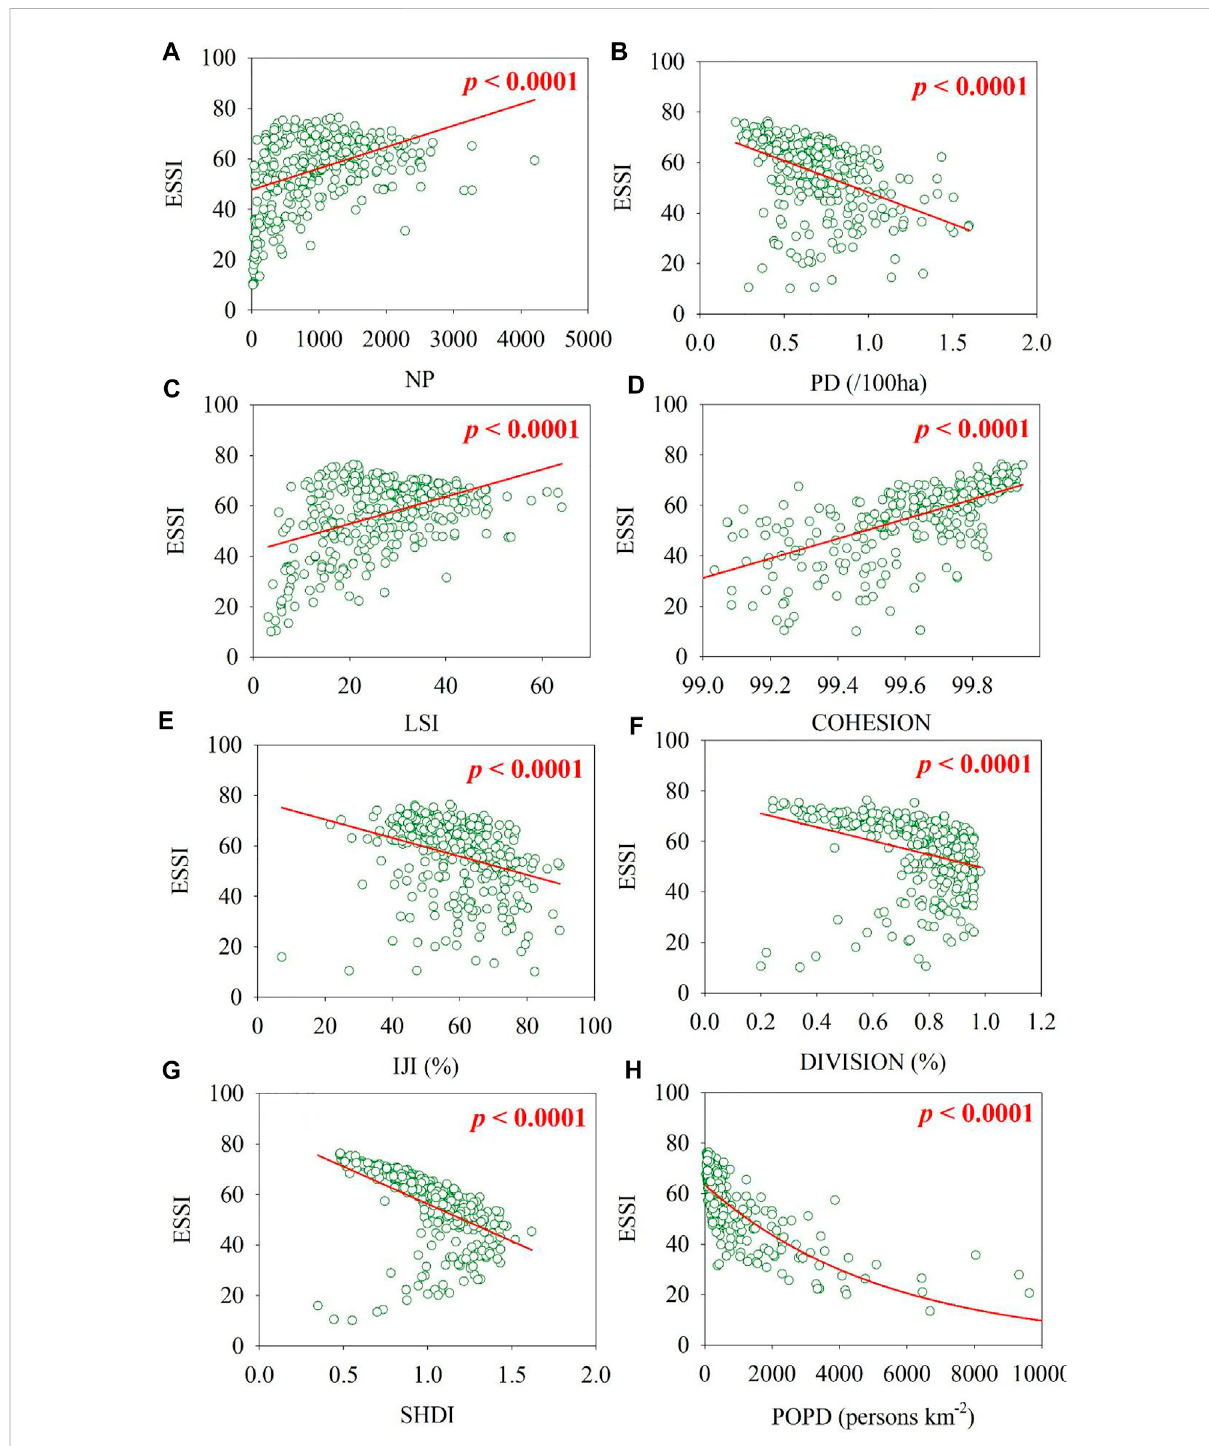
FIGURE 7 Associations between the ESSI and landscape and socioeconomic variables: (A) NP, (B) PD, (C) LSI, (D) COHESION, (E) IJI, (F) DIVISION, (G) SHDI, and (H)